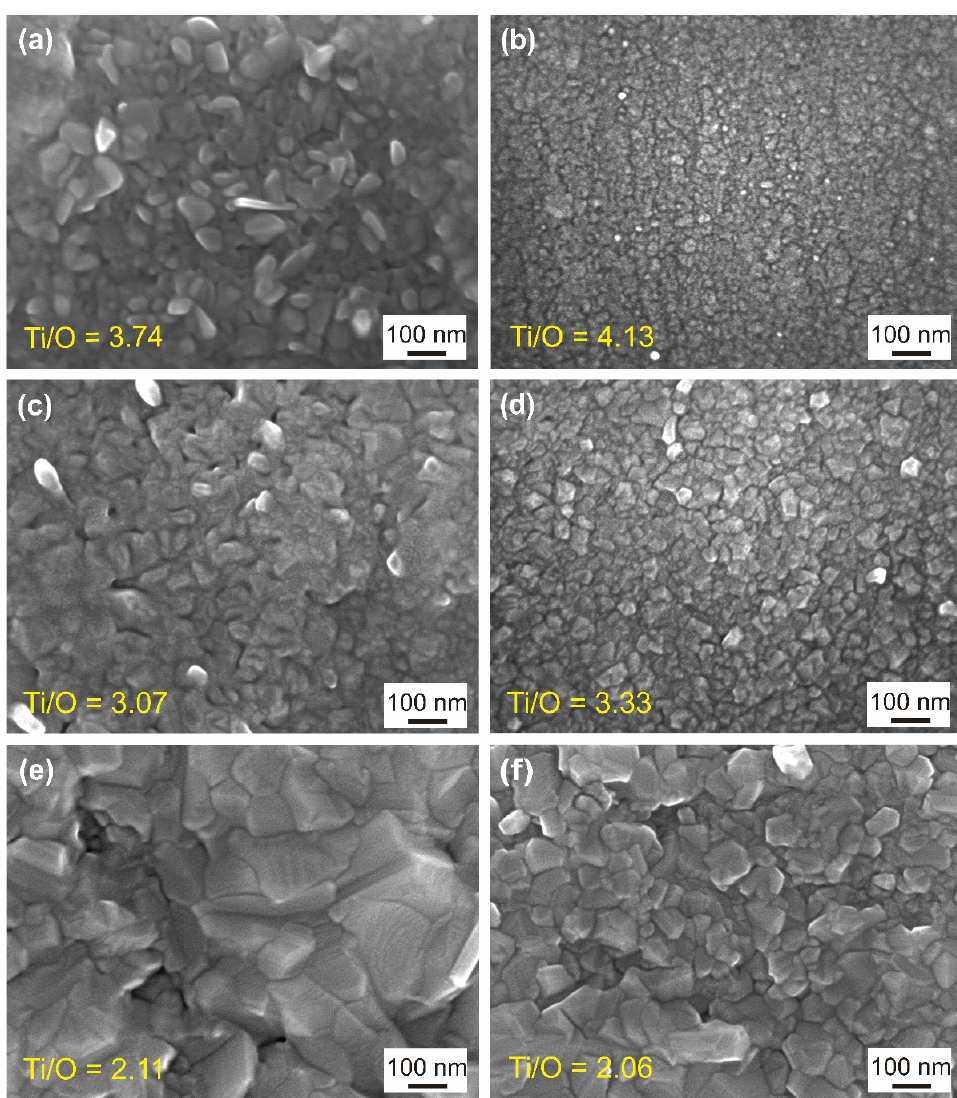
Figure 3. SEM images of titanium surface after IHT for 13 s ( a ), 20 s ( c ) and 25 s ( e ), ultrasonic-assisted IHT for 13 s ( b ), 20 s ( d ) and 25 s ( f ).